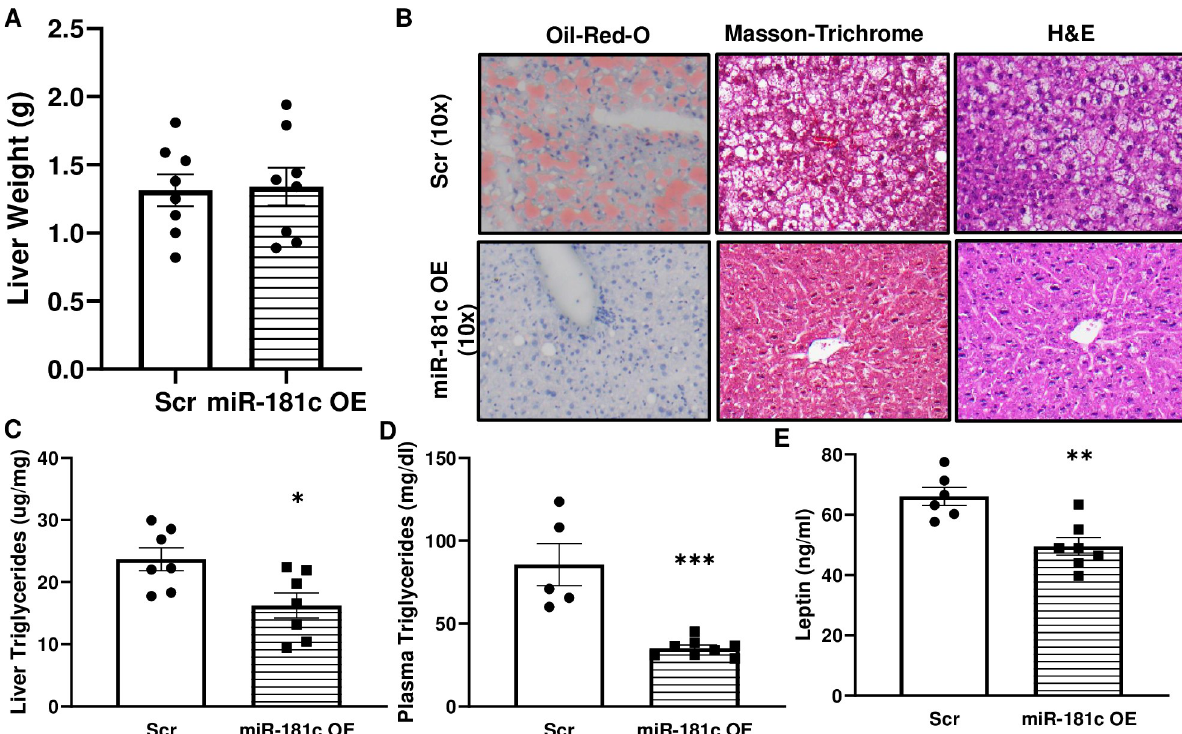
Fig 10. Effect of liver-specific miR-181c overexpression on metabolic consequences of a high-fat (HF) diet. AAV-8-miR-181c-injected and AAV- 8-scramble-injected mice were compared after 10 weeks of a HF diet. (A) Total liver weight. (B) Liver histology, Oil-Red-O staining, Masson- Trichrome, and H&E staining. (C) Liver triglyceride content. (D) Plasma triglyceride levels. (E) Plasma leptin levels. OE, overexpression; Scr, scrambled oligonucleotide. Data are expressed as mean ± SEM; n = 8 per group. � p < 0.05 by Bonferroni post hoc analysis after intergroup differences were found by 1-way ANOVA. � p < 0.05, �� p < 0.01, ��� p < 0.001 by two-sample